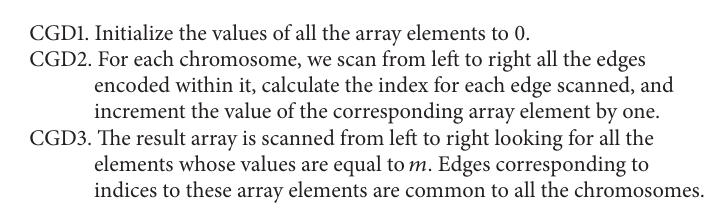
Algorithm 3: Outline of common genes detection algorithm.